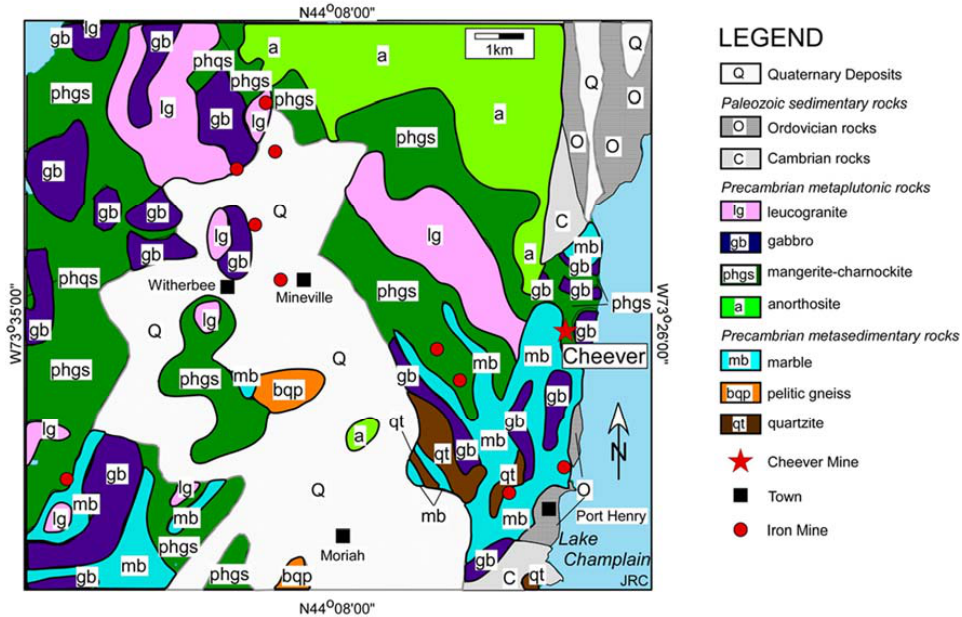
Figure 3. Map of the eastern Adirondack iron oxide-apatite (IOA) mining district.